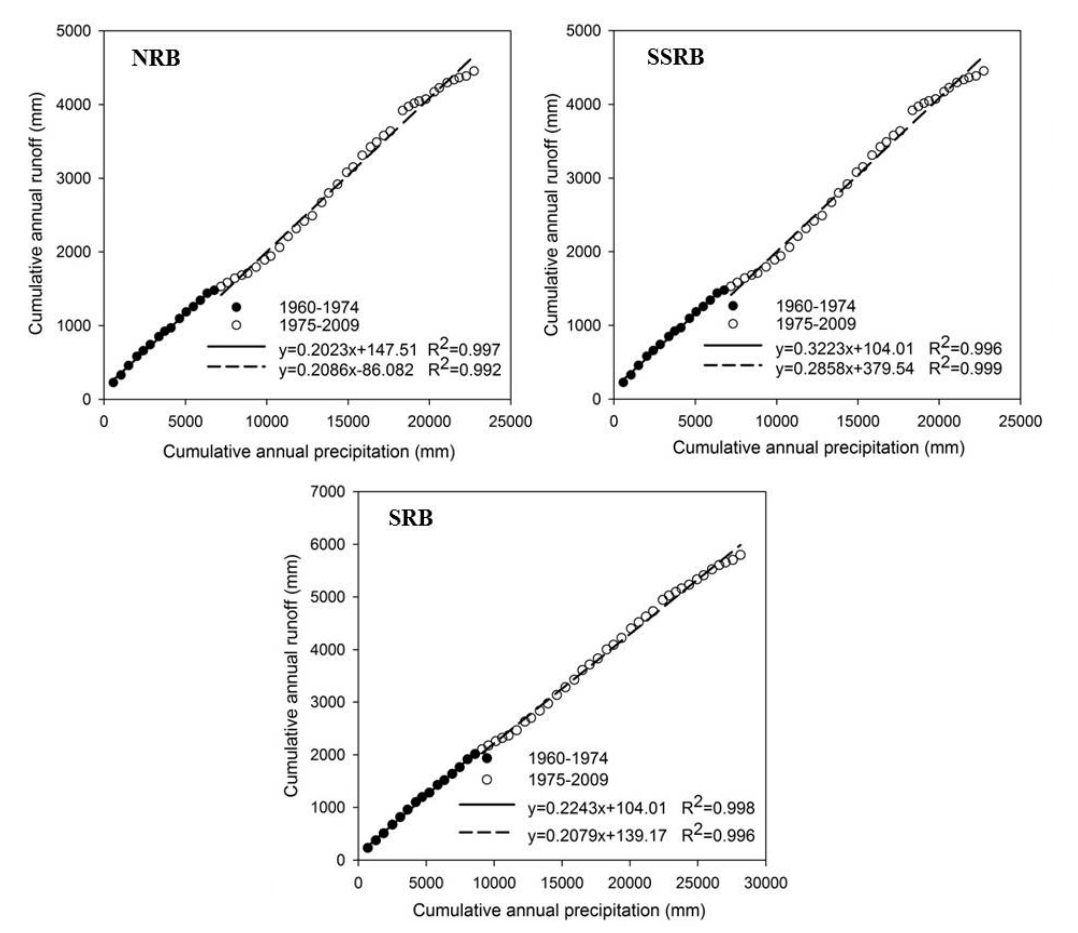
Figure 3. Double cumulative curve (DCC) of annual precipitation and runoff in the Songhua River Basin (SRB) and its two tributary basins, the Nenjiang River Basin (NRB) and Second Songhua River Basin (SSRB) in Northeast